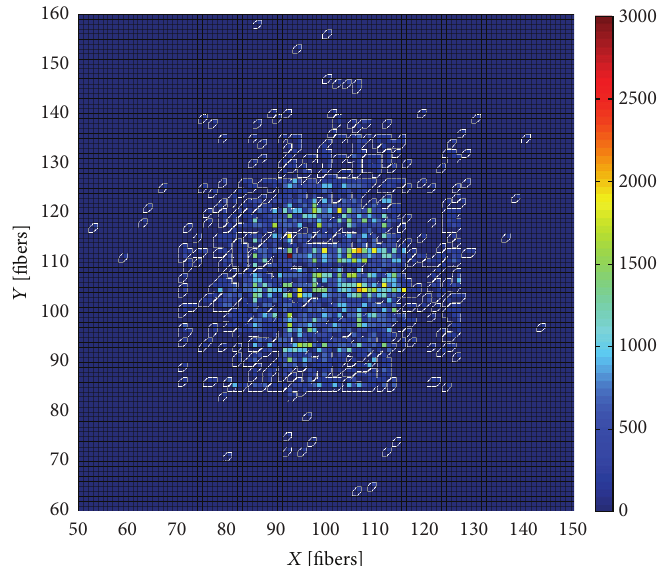
Figure 16: Real-time image of a 3 KBq 90 Sr 𝛽 source acquired by the OFFSET tracker. Axis units are in fibers number. The exposure time, needed to reach the three millions of events prefixed for the image, is of about 30 minutes.